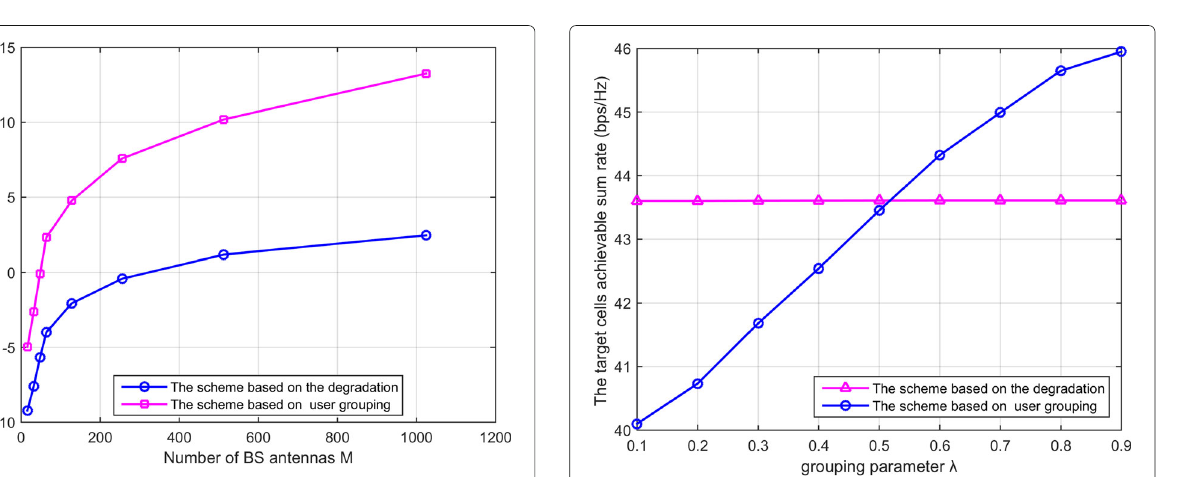
Figure 6 plots the target cell’s achievable sum rate when